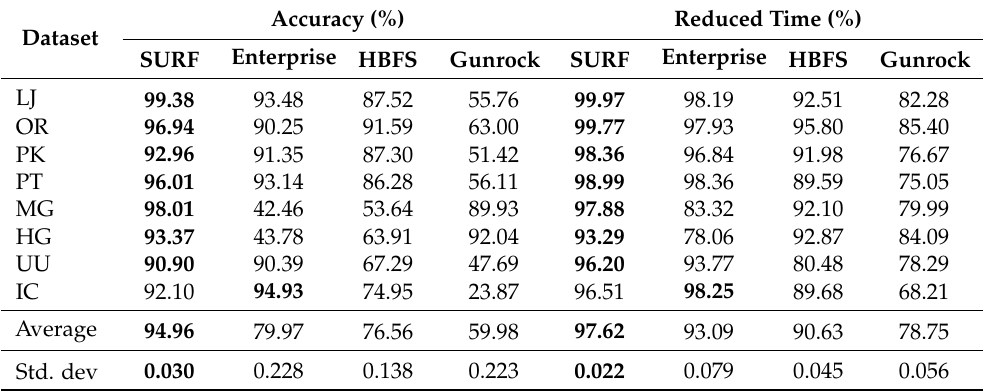
Table 3. Accuracy of direction prediction and reduced execution time by direction selecting based on the prediction according to the direction-optimizing methods. The standard deviation is abbreviated as Std. dev. A lower Std. dev is better. The best case among the four methods is listed in bold.